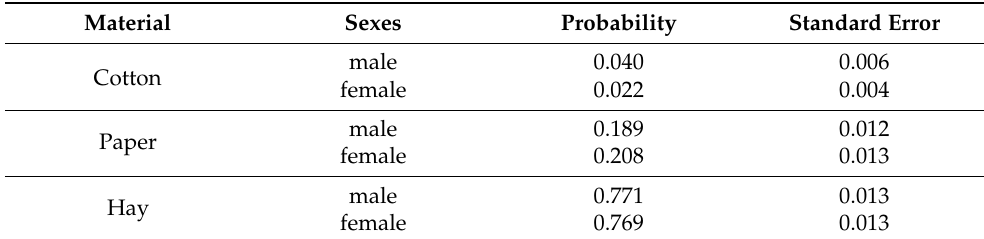
Table 2. The predicted probability of nest selection estimated by sexes.